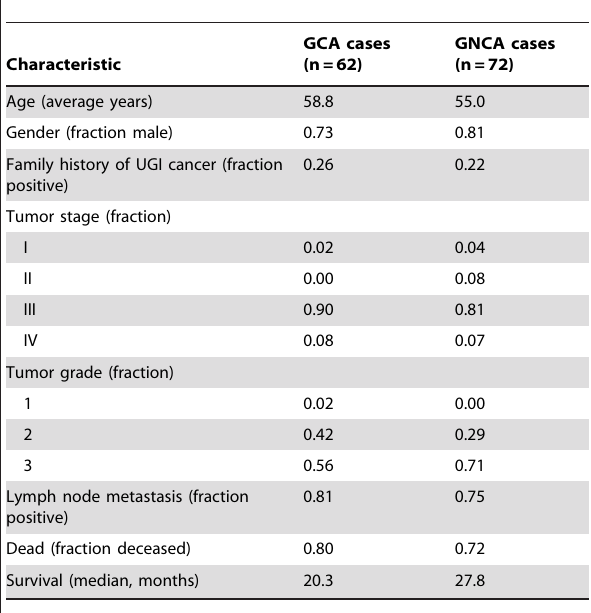
Table 1. Summary of personal and clinical characteristics of gastric cardia adenocarcinoma (GCA) and gastric noncardia adenocarcinoma (GNCA) cases.